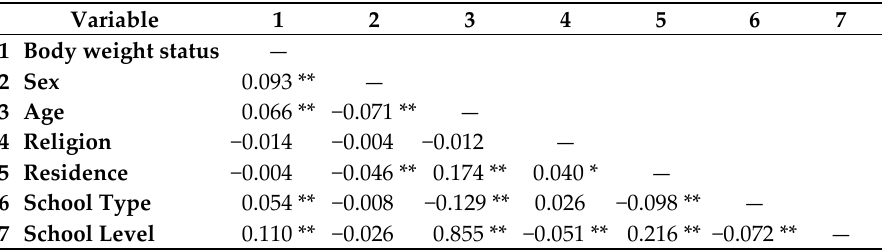
Table 2. Correlation coefficient between body weight status and demographic characteristics.